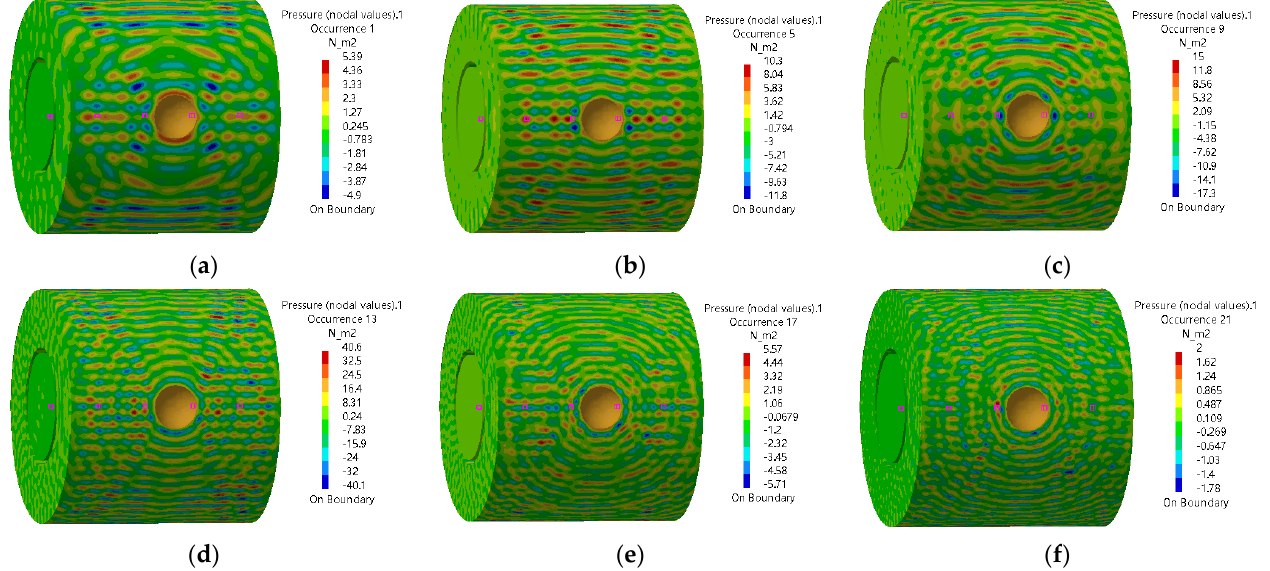
Figure 11. Sound pressure distribution in the annulus region and inside the oil pipe. ( a ) 20,000 Hz ( b ) 24,000 Hz ( c ) 28,000 Hz ( d ) 32,000 Hz ( e ) 36,000 Hz ( f ) 40,000 Hz.